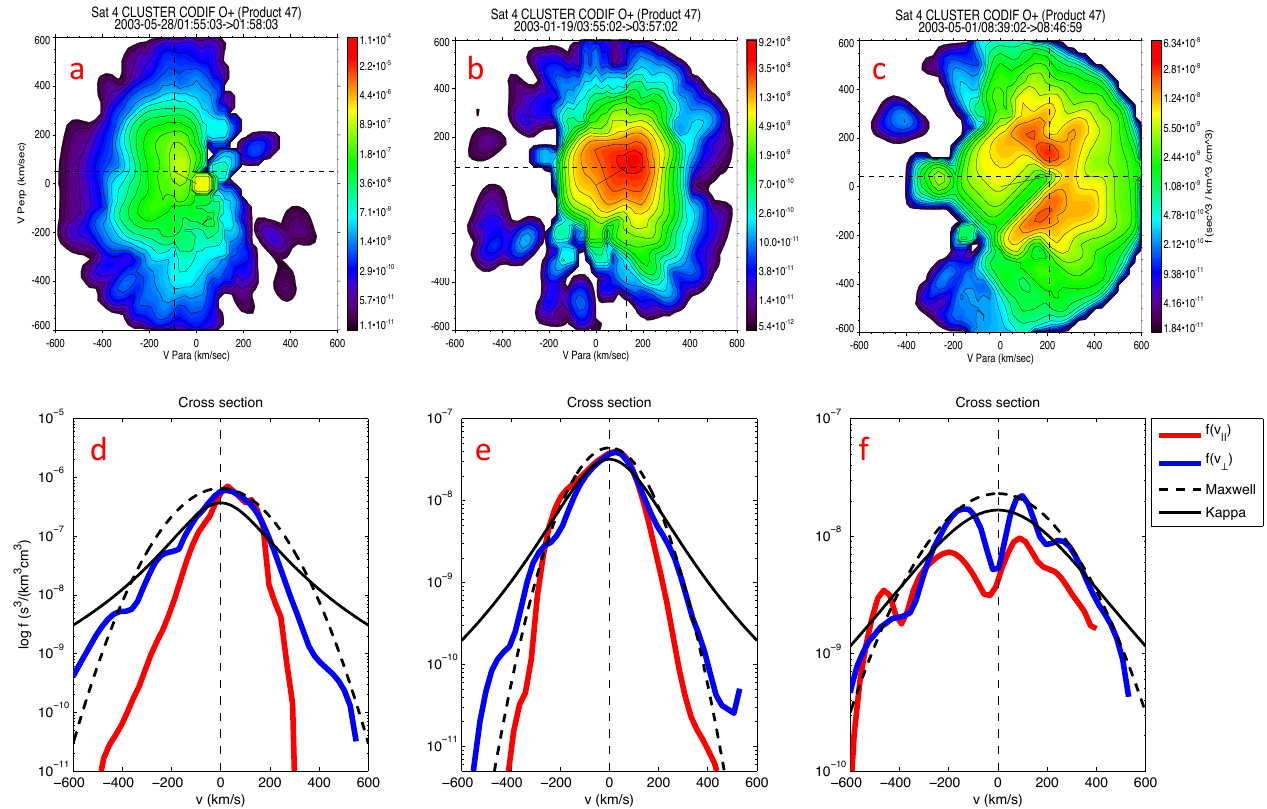
Fig. 4. Velocity space distribution functions of O + ions for Event 1 (a) , Event 2 (b) and Event 3 (c) , respectively. The lower plots ( d , e , f ) show the corresponding cross sections of the distribution functions in the reference frame of the plasma. Also plotted are Maxwell distributions (dashed black) and Kappa distributions (solid black), corresponding to the observed perpendicular temperature for each event and with κ = 1 .